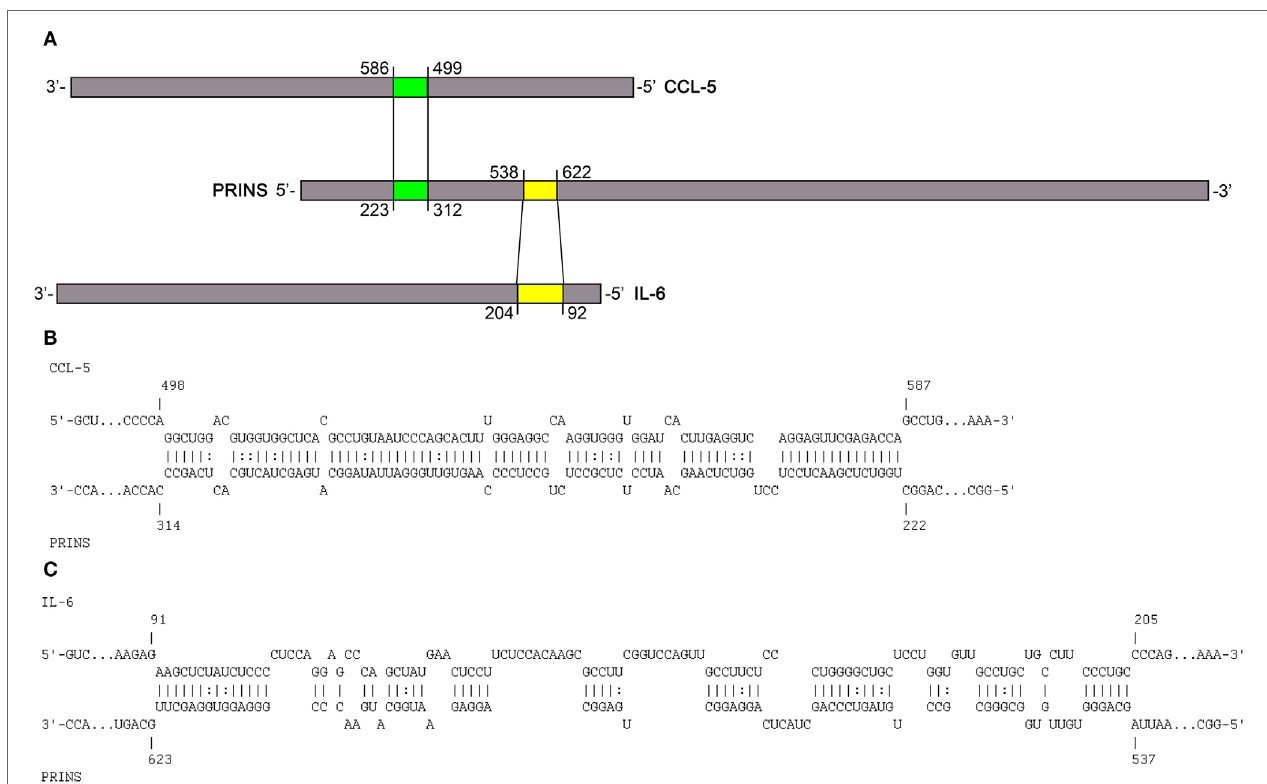
FigUre 4 | Putative interactions between PRINS long non-coding RNA and chemokine (C-C motif) ligand 5 (CCL-5) and interleukin-6 (IL-6) mRNAs. Schematic representation of the in silico predicted interaction sites in the PRINS sequence for the CCL-5 and IL-6 mRNAs (a) . PRINS sequences predicted to interact with CCL-5 mRNA (B) and IL-6 mRNA (c) . Nucleotide positions are given based on the AK022045, NM_000600.4, and NM_002985.2 reference